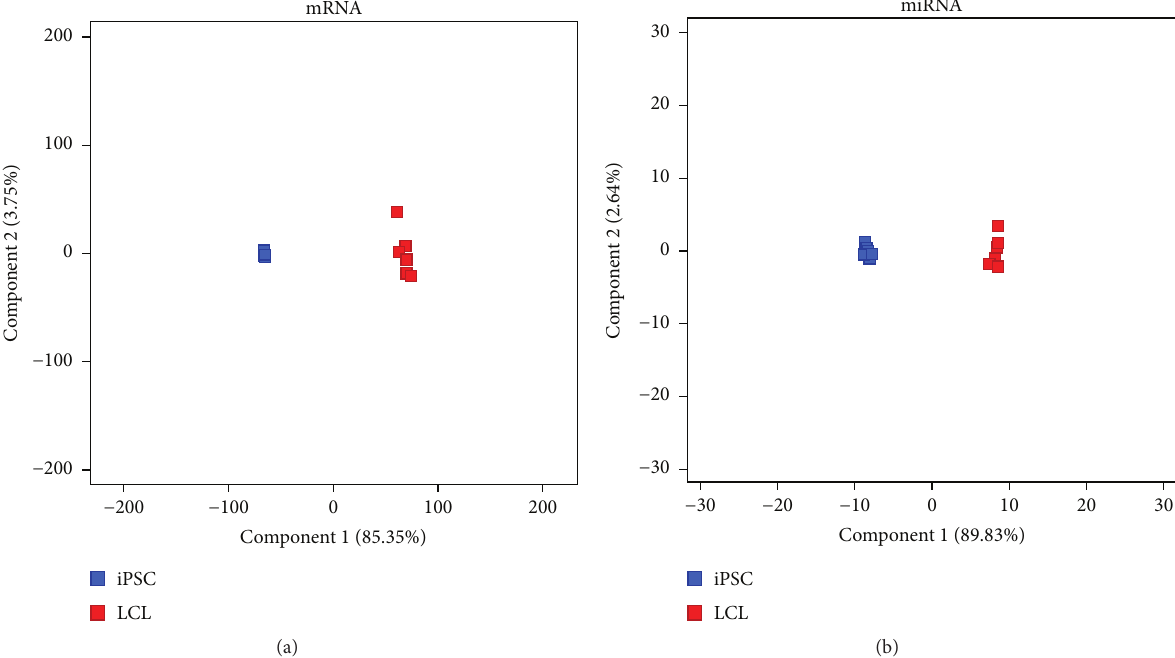
Figure 3: Principal component analysis (PCA) based on DE genes. (a) DE mRNAs during LCL-to-iPSC reprogramming. (b) DE miRNAs during LCL-to-iPSC